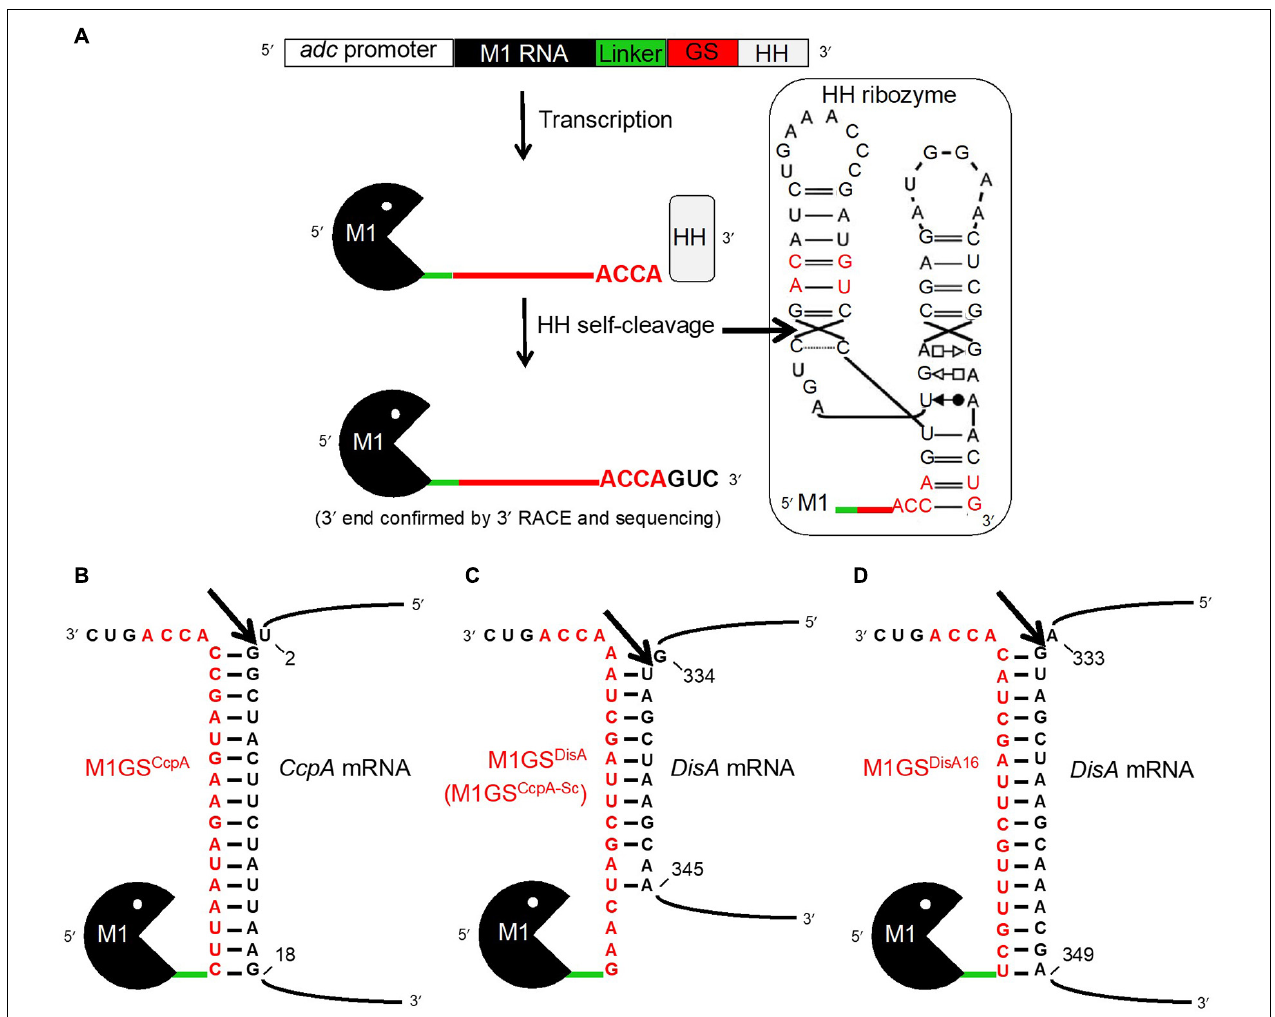
FIGURE 1 | The M1GS approach. (A) The M1GS construct was transcriptionally controlled by the C. acetobutylicum adc promoter. A 51-nucleotide linker between M1 RNA and the GS was engineered to allow flexibility between them. After transcription, the hammerhead (HH) ribozyme self-cleaved with high efficiency at the precise location indicated by the arrow in the inset, leaving the M1GS transcripts with only three additional 3 (cid:48) nucleotides. The inset shows the M1GS transcript with the full secondary structure of the HH ribozyme; the red-colored nucleotides are those that were modified to facilitate cloning and to minimize the number of additional bases at the 3 (cid:48) ends of M1GS. Annealing of M1GS CcpA (B) , M1GS DisA (C) , and M1GS DisA16 (D) to their respective target mRNAs. The numbers indicate the nucleotide positions targeted by the ribozymes in the mRNAs (with AUG numbering 1-3). The arrows indicate where the tethered M1 RNA is expected to cleave the